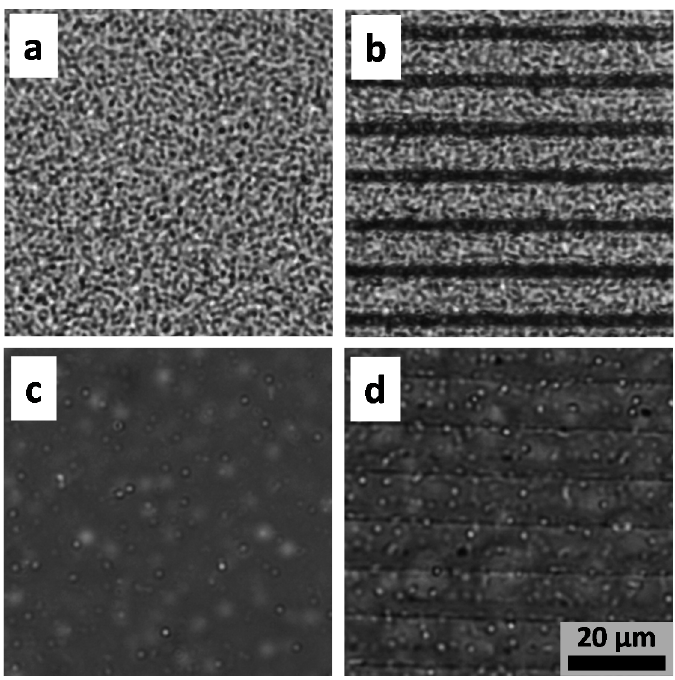
Figure 4. Optical microscope images of microenvironments with biofilm formation on the unpatterned ( a ) and micropatterned ( b ) PMMA surfaces; and unpatterned ( c ) and micropatterned ( d ) chitosan surfaces.